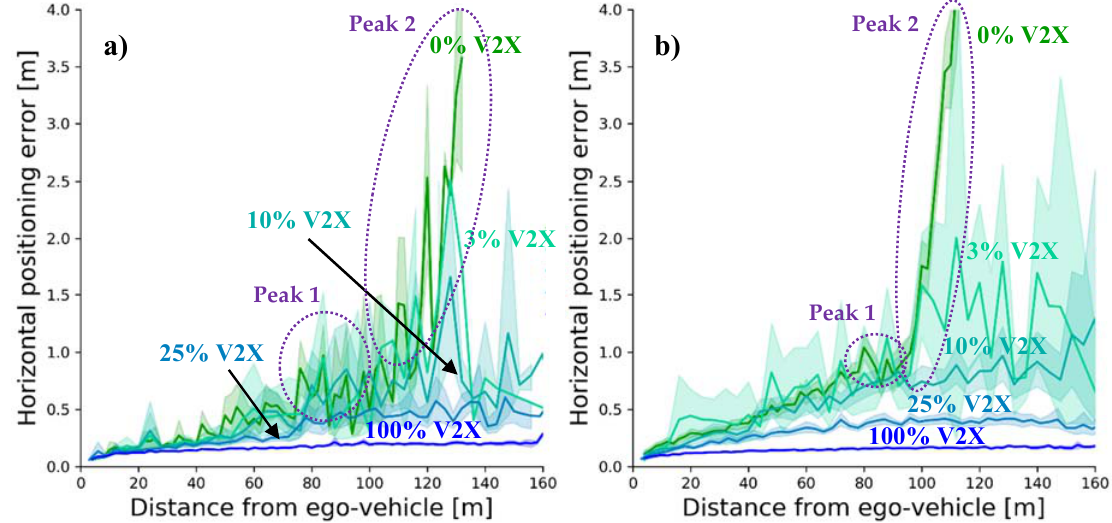
Figure 12. Object Tracking Accuracy and their standard deviations for ( a ) the low traffic scenario and ( b ) the high traffic scenario in dependence of the V2X equipment rate and the distance to the ego ‐ vehicle.